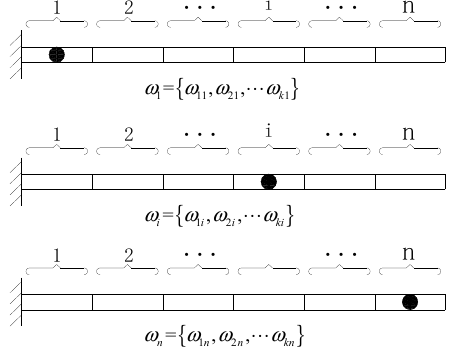
Figure 1. Schematic diagram of additional masses.